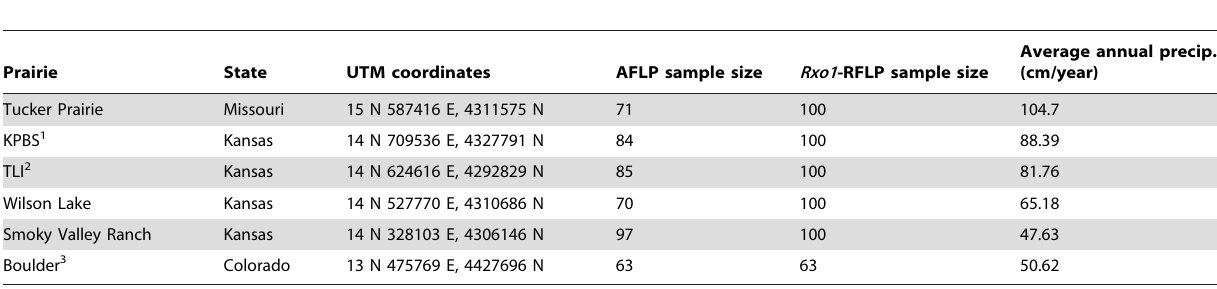
Table 1. Tallgrass prairies sampled, with state, UTM coordinates, AFLP sample size, Rxo1 -RFLP sample size and average annual precipitation from the nearest weather station